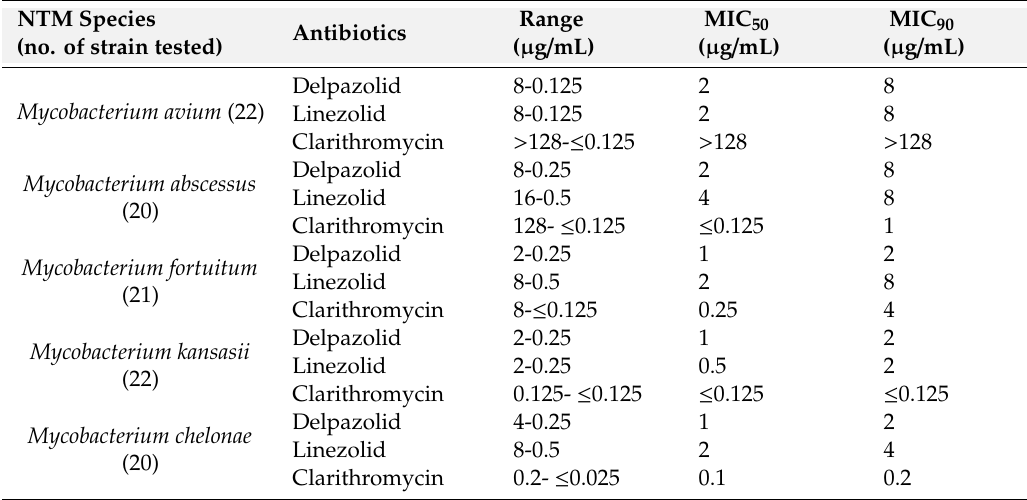
Table 7. MICs of antibiotics against clinical isolates of